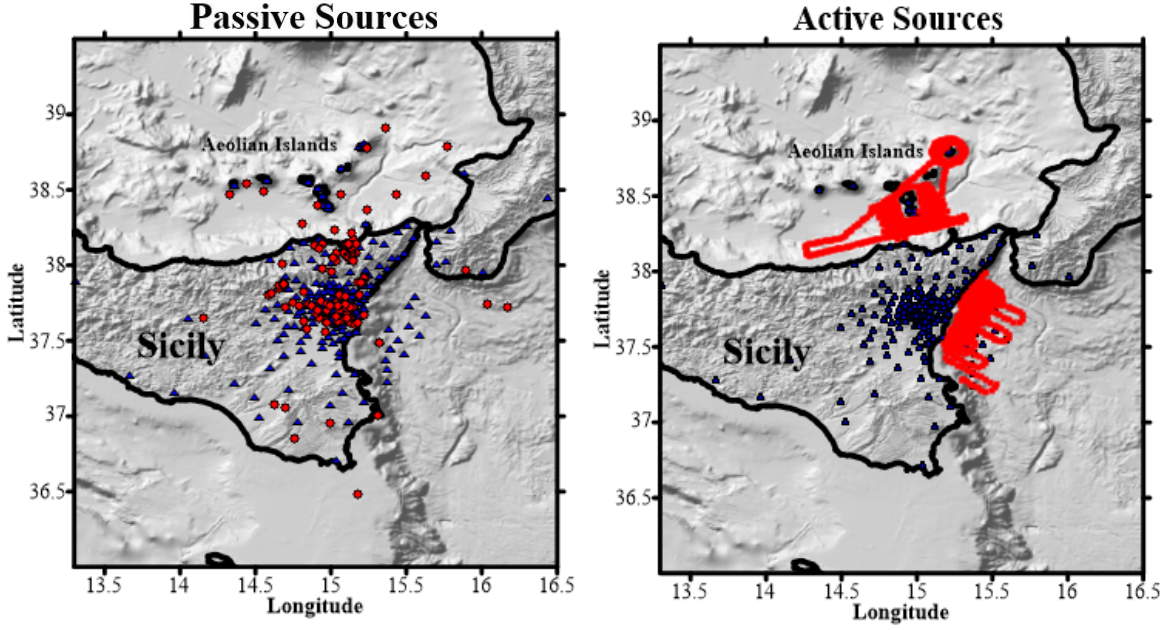
Figure 2. (a). Map of the passive dataset with the stations (blue triangles) that registered the events (red dots). (b) Map of the active source distribution including the seismic network used to register the shots (red